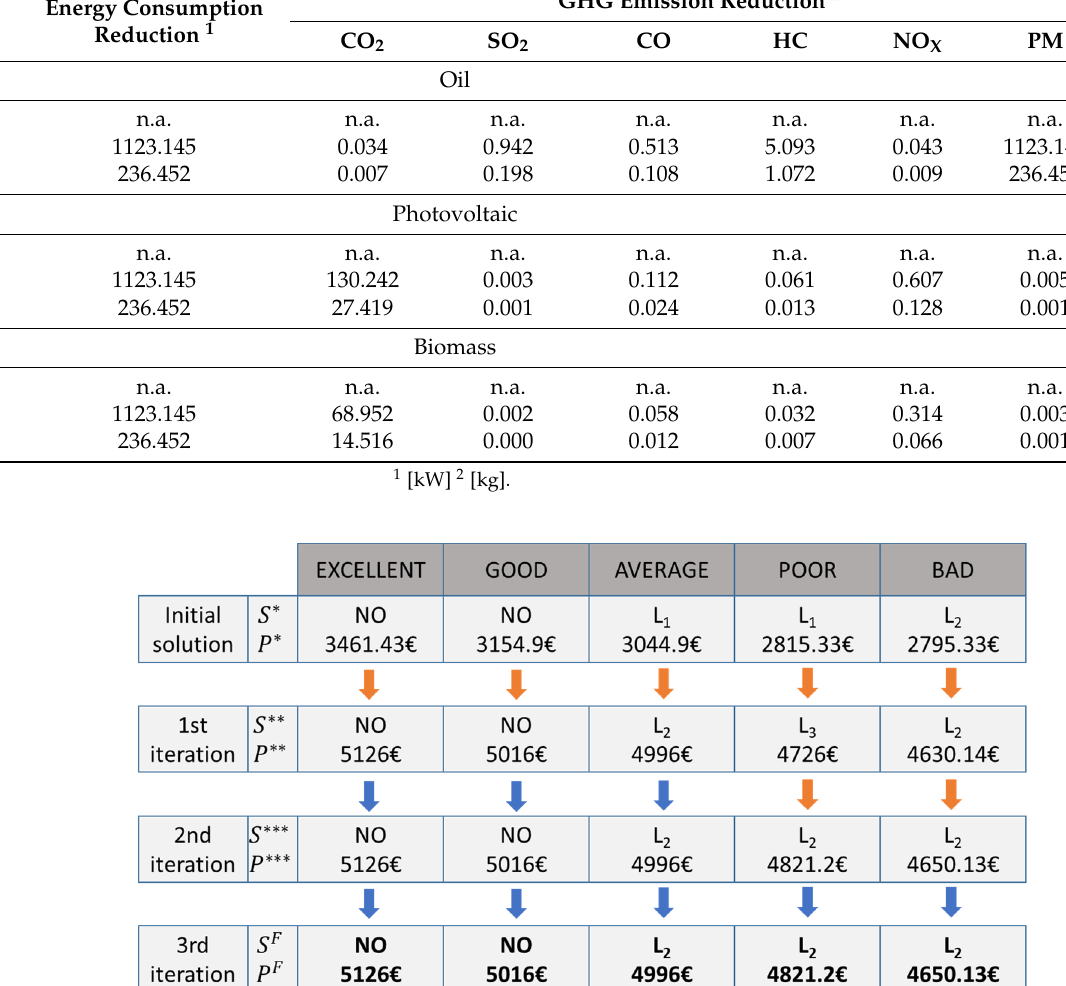
Figure 9. Impact of the discounting parameter on the discounted energy-consumption-based profit resulting from the optimized maintenance policy in the case of different initial status of the system (best status is Status 1 and worst status is Status 5). The discounted profit depends on the initial status level of the system. Figure 10 demonstrates the influence of initial status level of the system on the discounted profit. As Figure 10 shows, the better status level causes higher discounted profit and the increased 𝜗 value also increases the discounted profit for all initial system statuses.